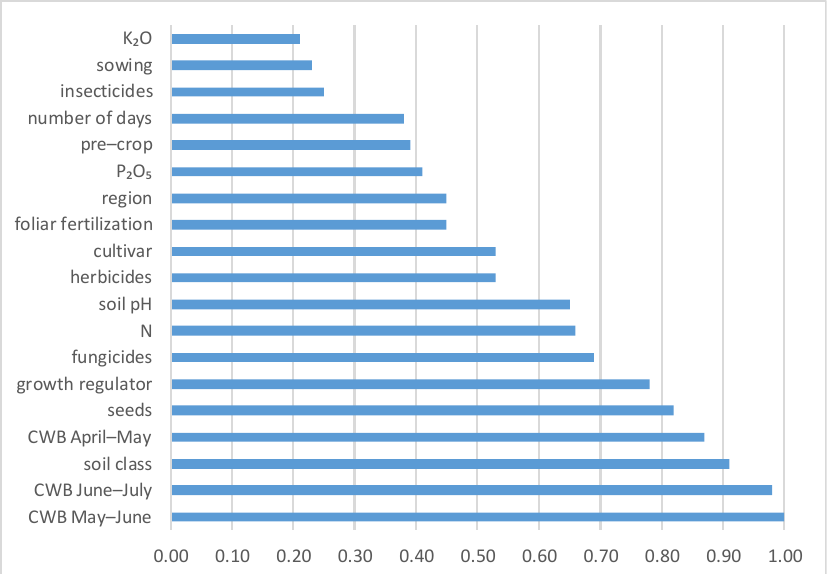
Figure 3. Importance of independent variables in the scale 0–1 (importance 0—variable is never featured in the tree, importance 1—the highest importance in the explanation of yield variability) for winter triticale.